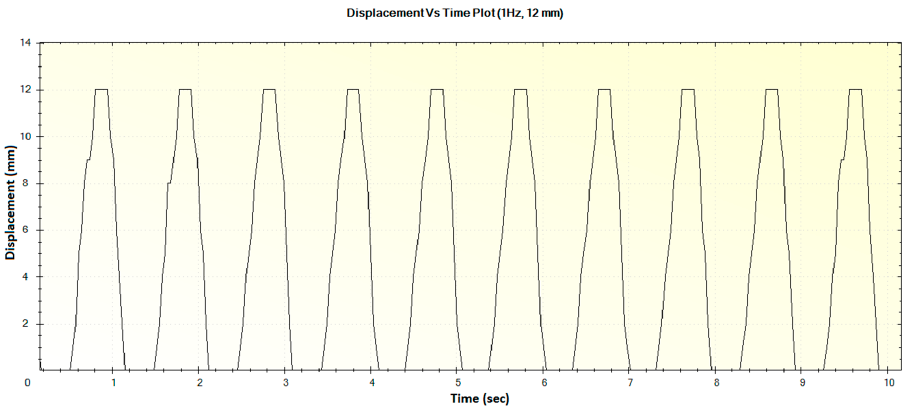
Figure 18. Generated waveform for 1 Hz operation producing a displacement of 12 mm.